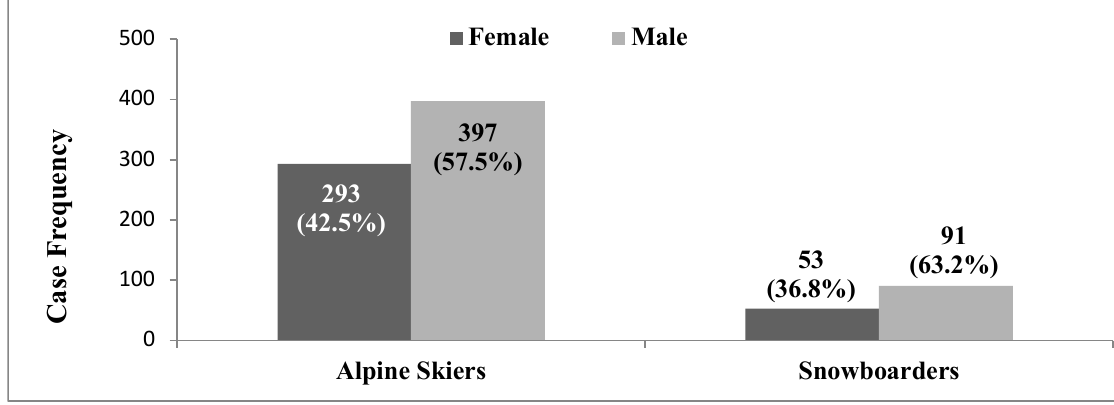
Figure 2. Injury frequency distribution for alpine skiers and snowboarders according to gender